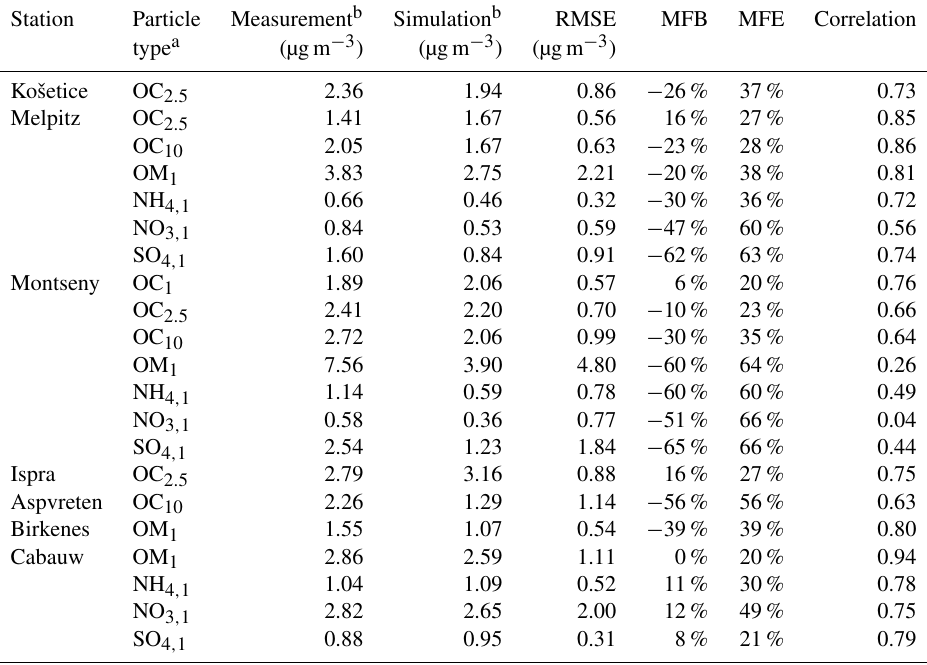
Table 4. Comparison of the simulated concentrations to the measurements. Performance statistics are calculated with daily mean concentra- tions.